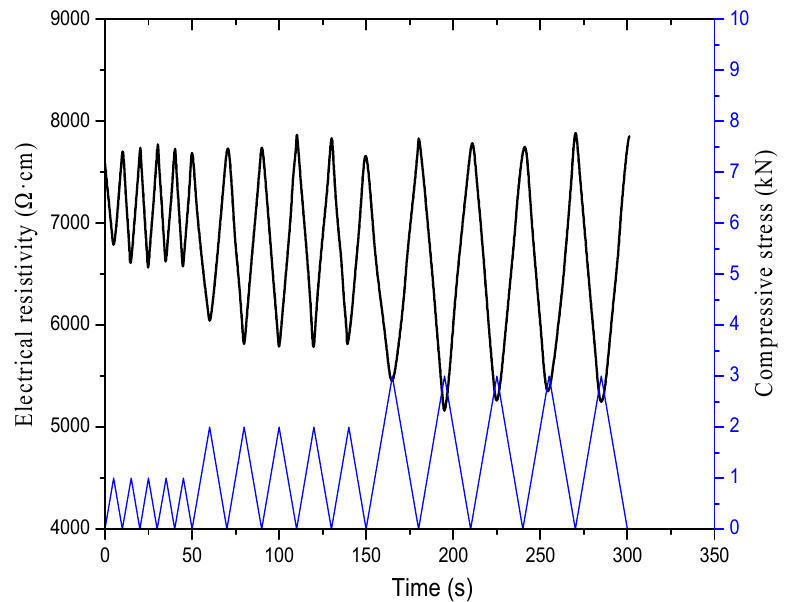
Figure 18. Relationship of electrical resistivity and compressive stress of specimens with 2% content of graphene under different loading amplitude after freeze–thaw.